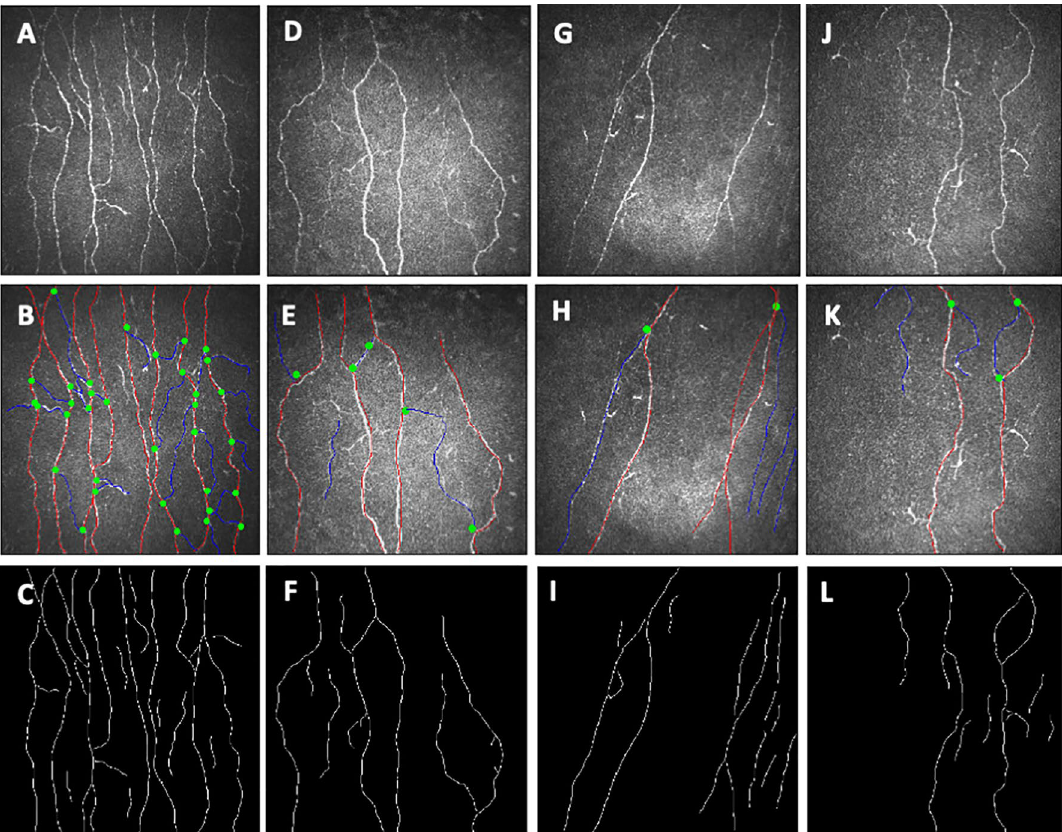
Figure 4. Row 1 ( A , D , G , J ): Original CCM images from a HC ( A ) and patients with CIS ( D ), RRMS ( G ) and SPMS ( J ) with identifiable corneal axonal loss. Row 2 ( B , E , H , K ): corresponding analyzed images with ACCMetrics to estimate CNFD (main fibers = red color), CNFL (fibers and branches = red and blue colors) and CNFrD. Row 3 ( C , F , I , L ): corresponding images analyzed with Voxeleron